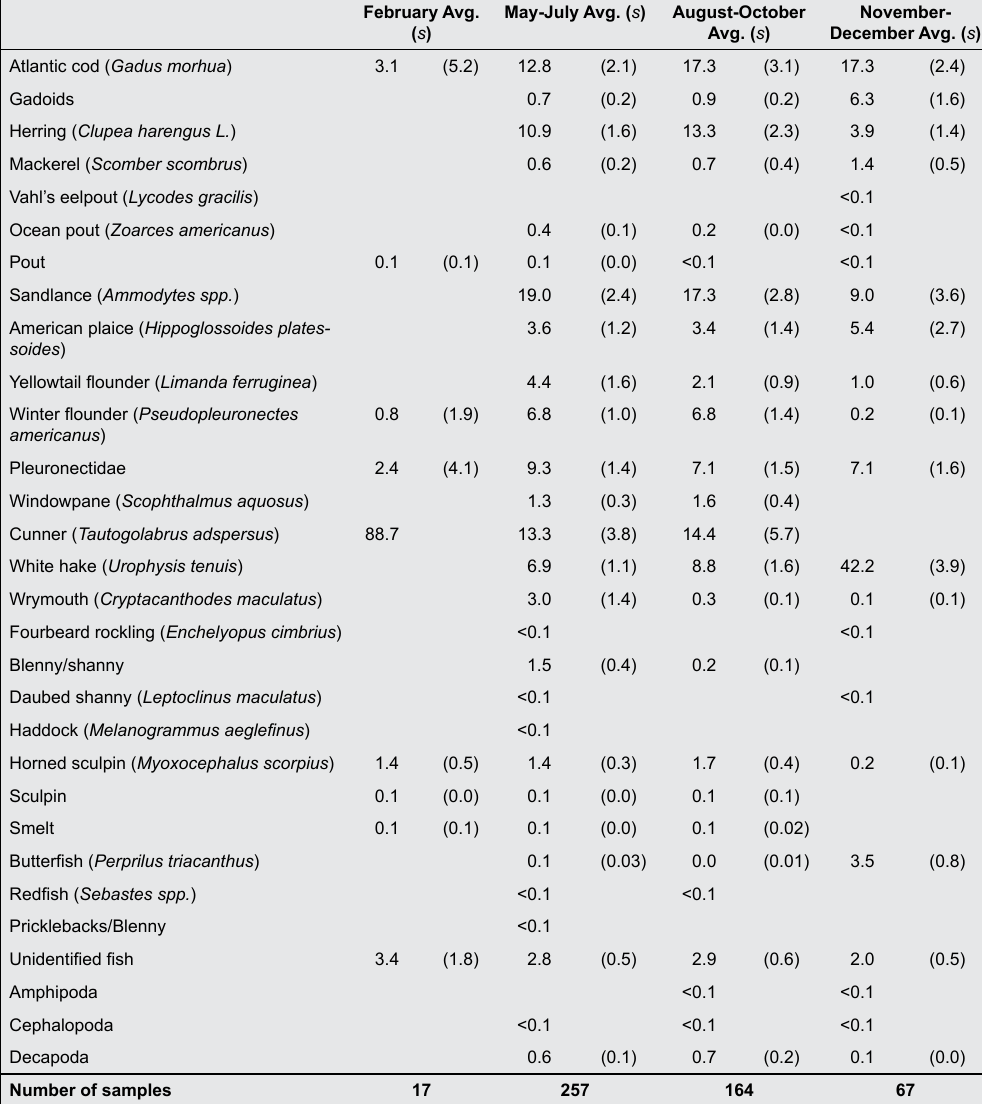
Table 6 . Percent mass contribution of different prey by season to grey seal diets from animals collected in the Southern Gulf of St. Lawrence between 1994 and 2003. Samples include all years combined. Average with standard deviation in